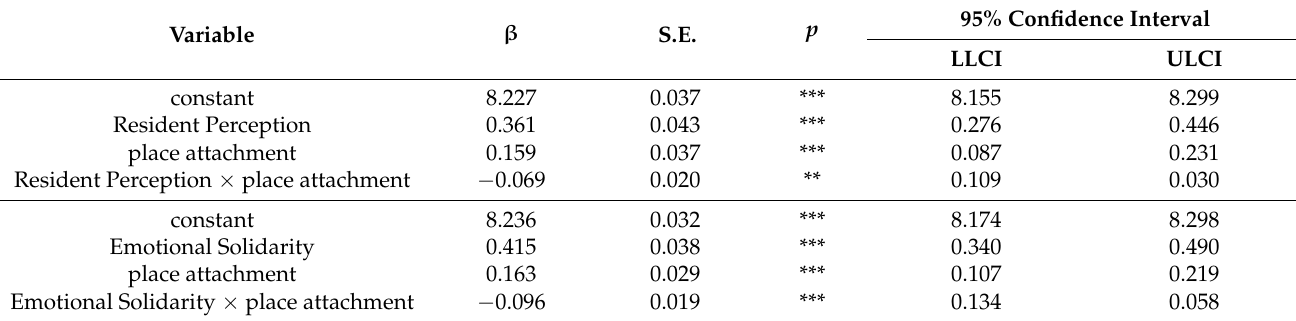
Table 6. Results of the moderating effect